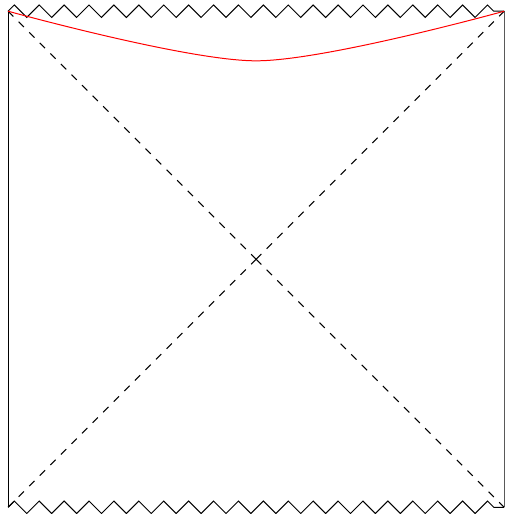
Figure 3. The basic setup of the CV conjecture. At very late times, the complexi(cid:12)cation rate _ C is proportional to the volume of the late-time maximal hypersurface at r = r (cid:3) , drawn in